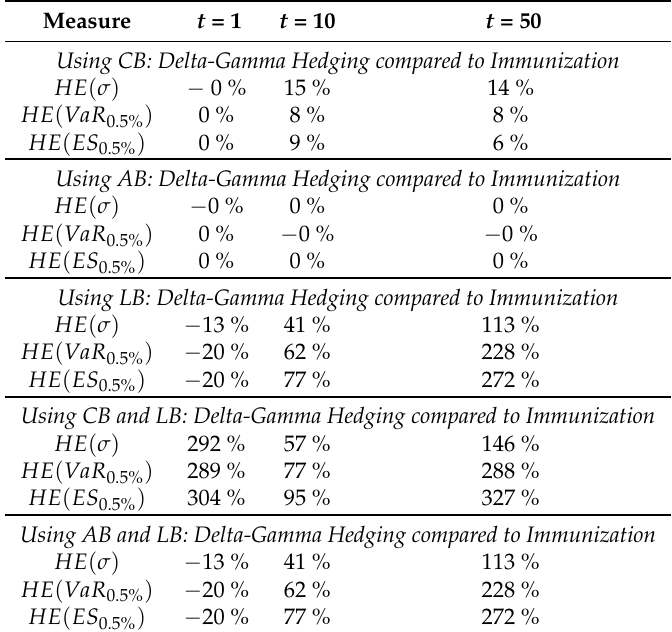
Table 18. Risk Reduction Measures—Comparison of Bond Selection